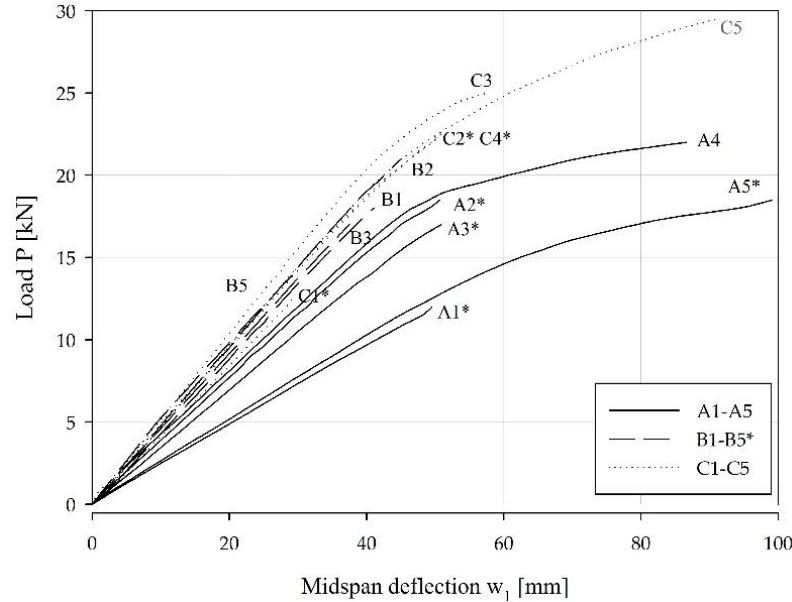
Figure 12. Load‐midspan deflection relationship of Series S1. * B4 was excluded from further analysis due to the change in cross section dimension.